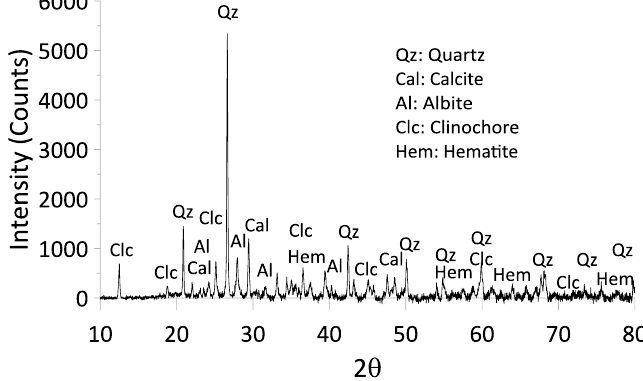
Figure 3. Mineralogical composition of the studied